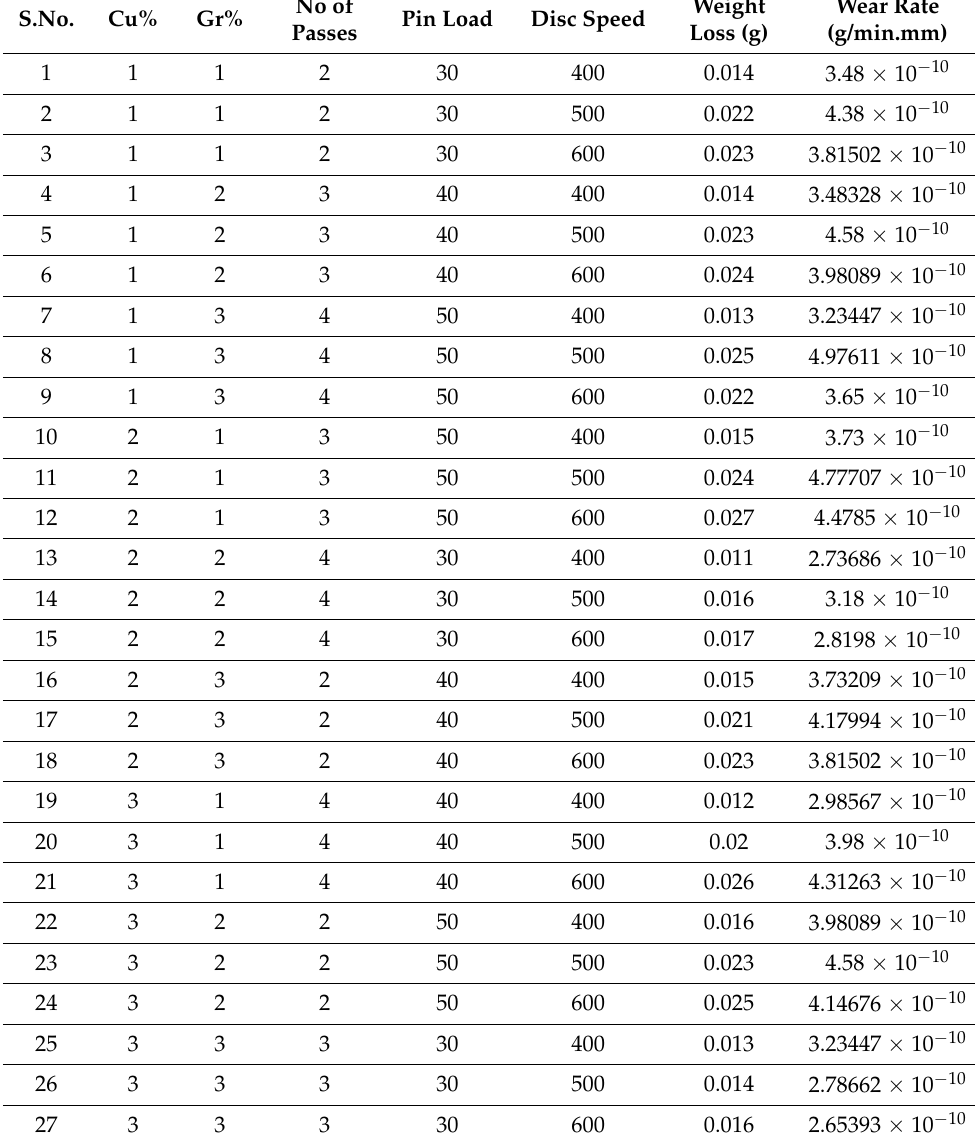
Table 2. Taguchi’s experiments designed for wear tests of the composites prepared by Tool A.